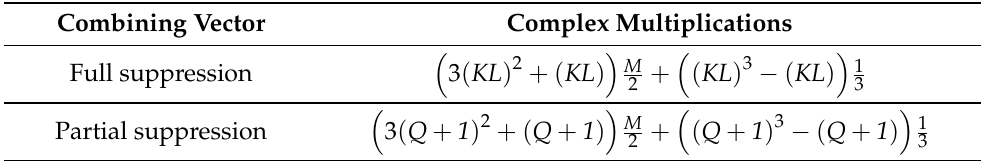
Table 1. Computational complexity required per E-ZF combining